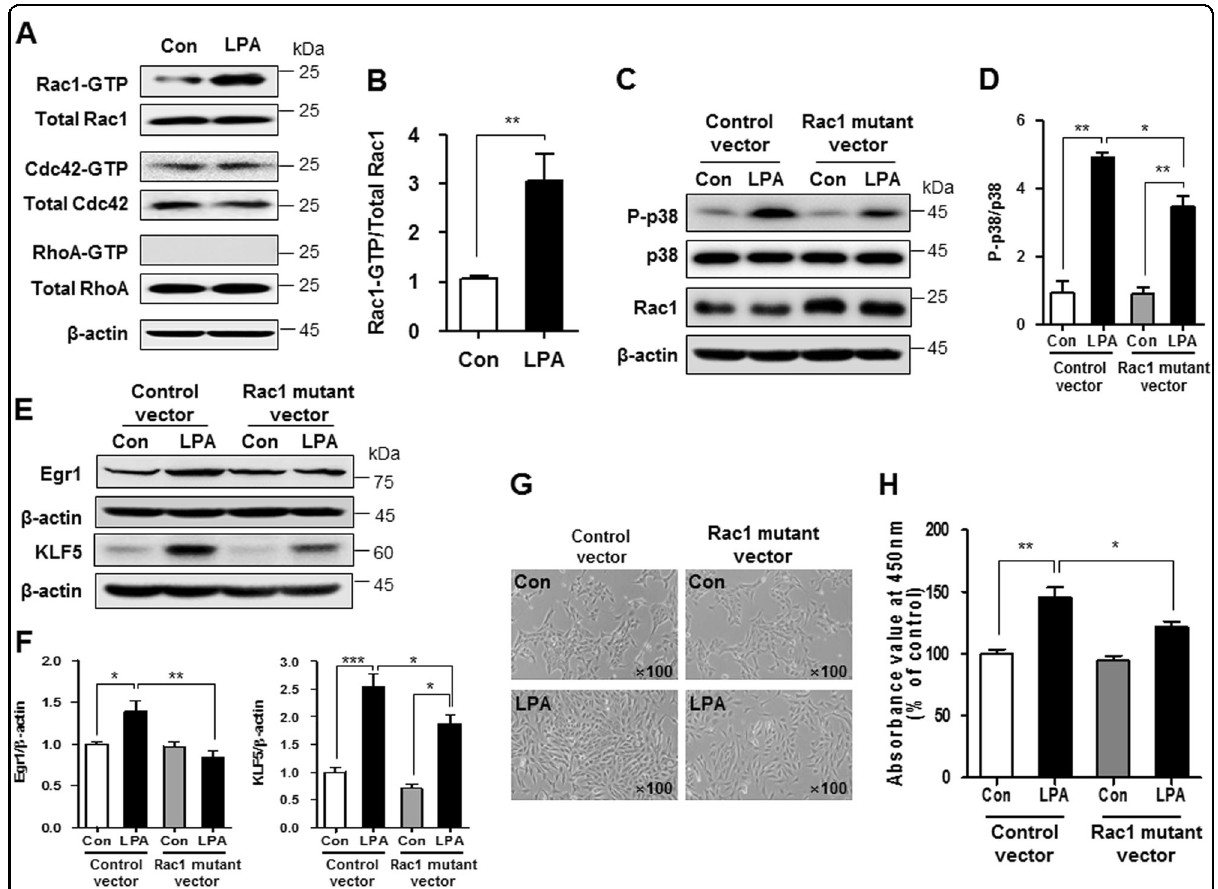
Fig. 6 LPA increases SV40 MES13 cell proliferation by activating the Rho GTPase Rac1. a Western blots showing the levels of the RhoA, Rac1, and Cdc42 proteins in cells treated with 10 μ M LPA for 5 min. RhoA, Rac1, and Cdc42 activity assays were performed using a GST-fusion protein derived from p21-activated kinase or rhotekin, which selectively binds to GTP-bound RhoA, Rac1, or Cdc42. GST – rhotekin precipitates were analyzed using western blotting. b The relative levels of active Rac1 were normalized to the levels of total Rac1 and quanti fi ed using ImageJ software ( n = 3 independent experiments). c , e After the transfection with the control vector or the dominant-negative Rac1 mutant, SV40 MES13 cells were treated with LPA (10 μ M) for 15 min (C) or 6 h (E). Western blots show the levels of p-p38, p38, Rac1, Egr1, KLF5, and β -actin proteins. d , f The relative levels of p-p38, Egr1, and KLF5 were normalized to p38 or β -actin and quanti fi ed using ImageJ software (n = 3 – 4 independent experiments). g Cell morphology was examined using light microscopy (original magni fi cation, × 100), and ( h ) cell proliferation was examined using the CCK-8 assay ( n